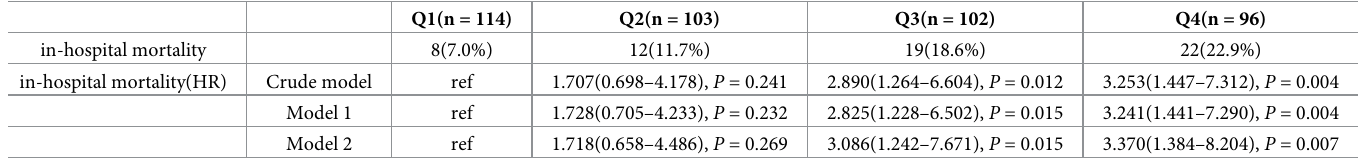
Model 1: Adjusted for age, gender; Model 2: Adjusted for age, gender, Stanford type, hypertension, diabetes, CAD, smoking, drinking, serum glucose, α -HBDH. For numerical raw data, please see S1